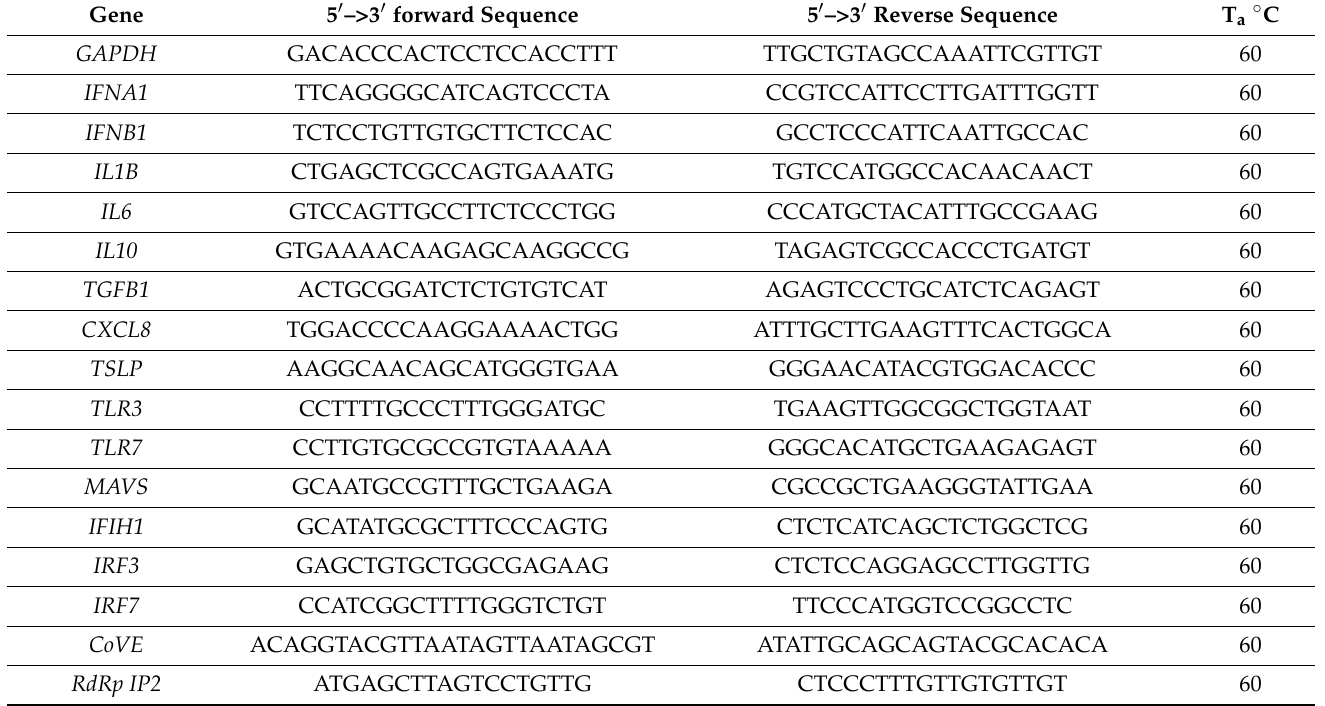
Table 1. Primers used in the study.